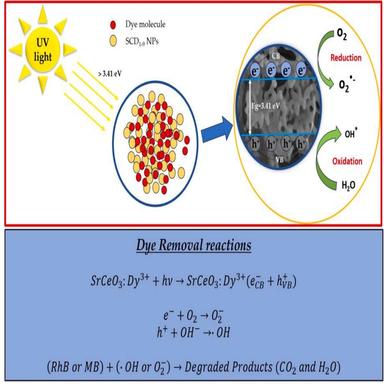
Degradation mechanism of Rh–B and MB dye molecules against SCD1-9 NPs.